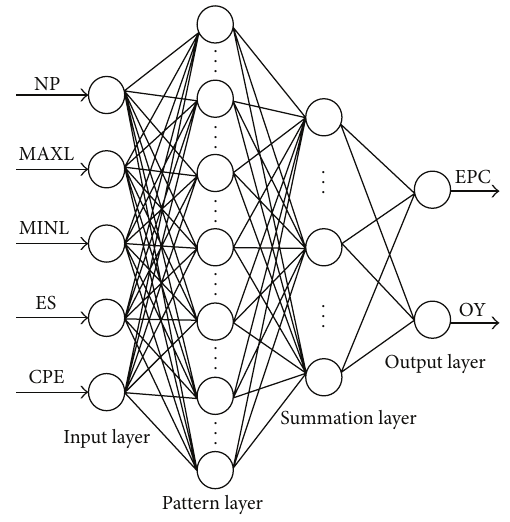
Figure 2: GRNN model of the beam pumping